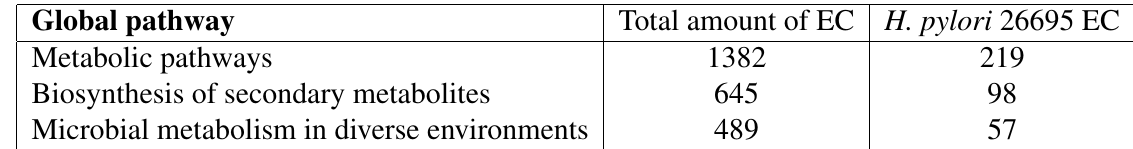
Table 5: EC number distribution in global